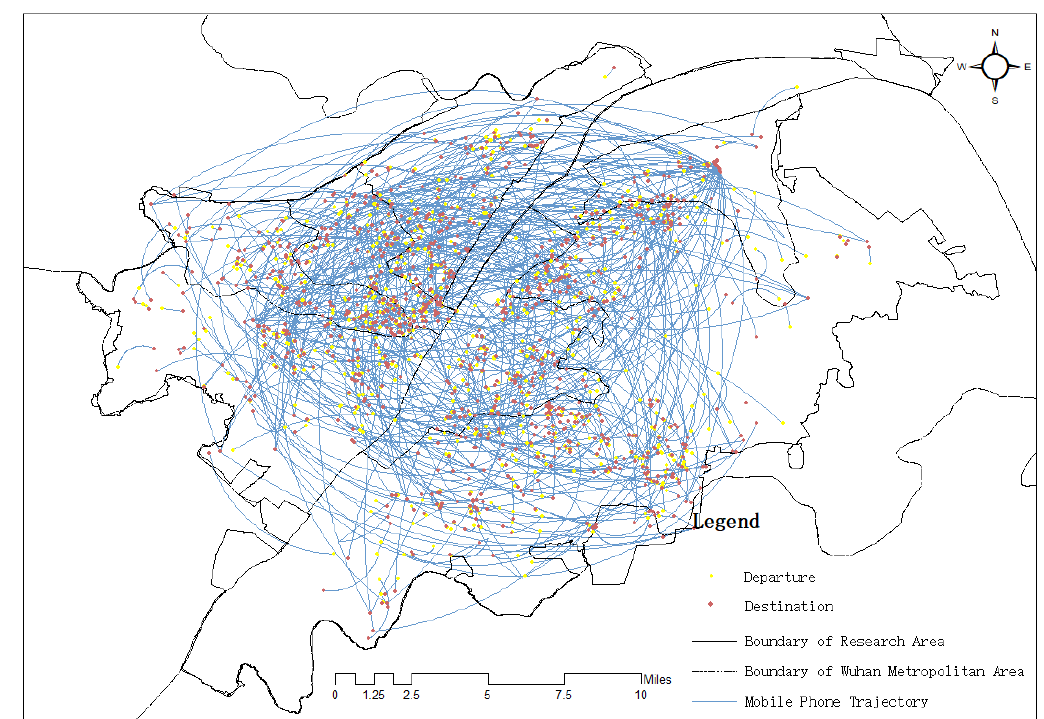
Figure 3. Mobile phone